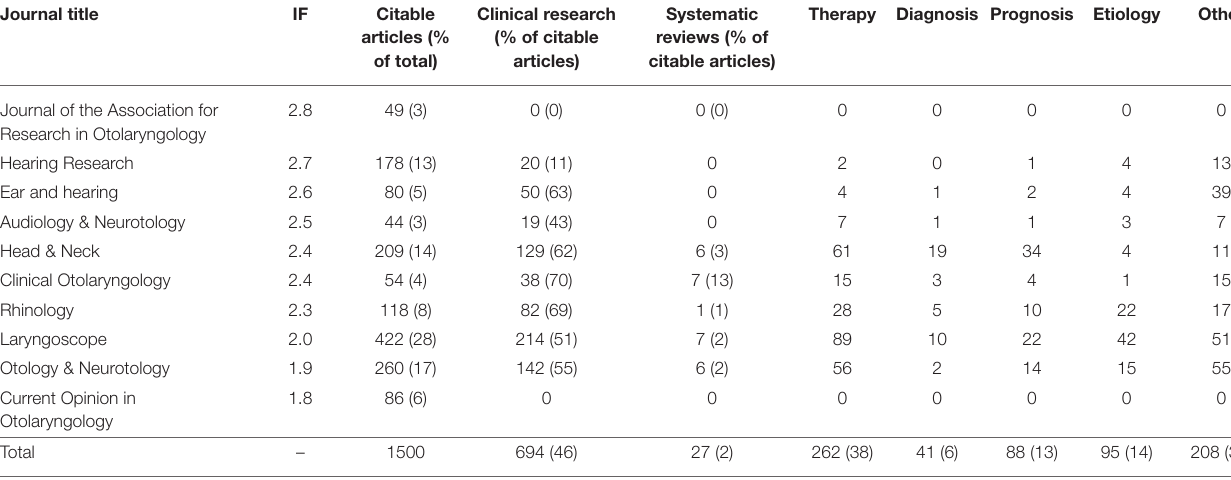
TABLE 3.1 | Results 1. Type of research in Otolaryngology journals.